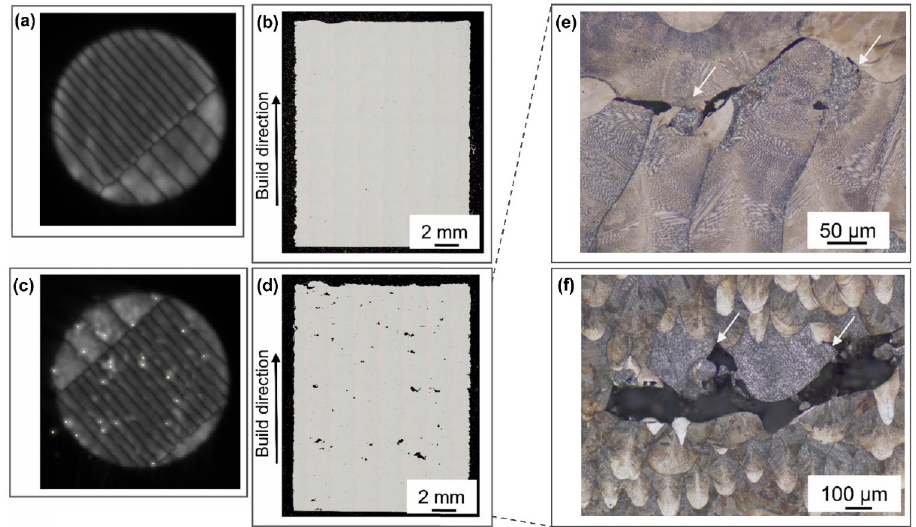
Figure 19. Cross section metallography of damaged testing [82]. ( a ) A low number of spatter rede- posits are detected in specimens manufactured in the proximity of the gas inlet. ( b ) Metallographic analysis of these specimens reveals no major internal defects. ( c ) Detections of spatter redeposits can be abundant in specimens manufactured in the proximity of the gas outlet, ( d ) and these specimens present large internal defects. ( e , f ) are round particles with dendritic structure neighbor and lack of fusion defects, indicated by white arrows. (Reprinted with permission from Ref. [82]. Copyright 2021 Elsevier B.V.).